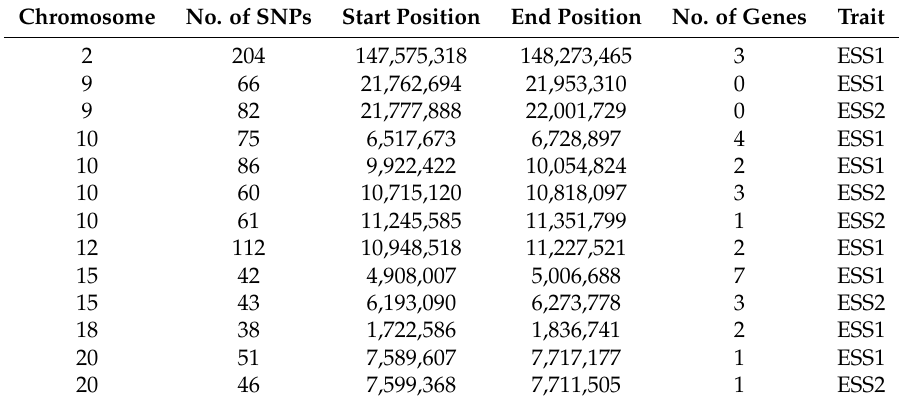
Table 1. Significant peaks as defined in Phase 4 of our analysis framework and corresponding quantitative trait loci (QTLs) for ESS1 and ESS2. Chromosome No. of SNPs Start